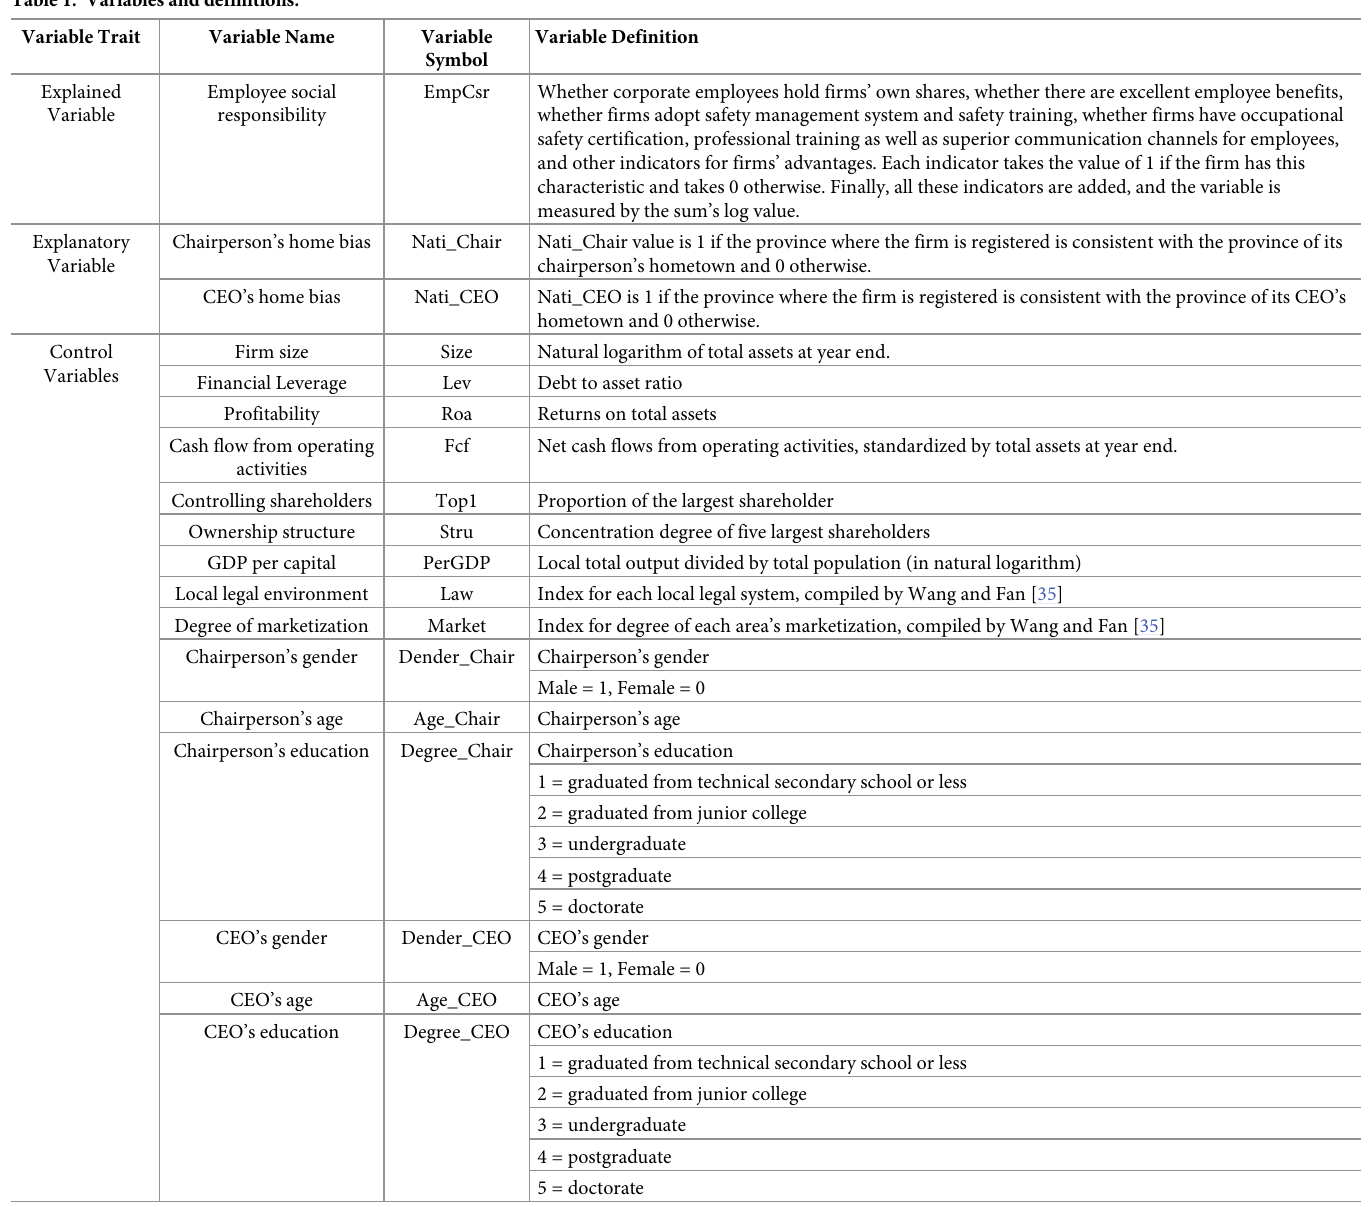
Table 1. Variables and